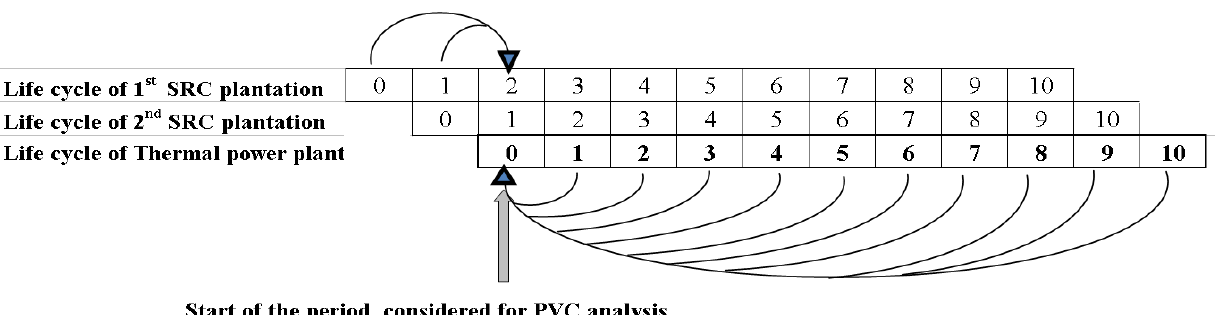
Figure 1. Scheme of the period (in years) considered for the economic evaluation of the Present Value of Costs (PVC) in a wood chip heating